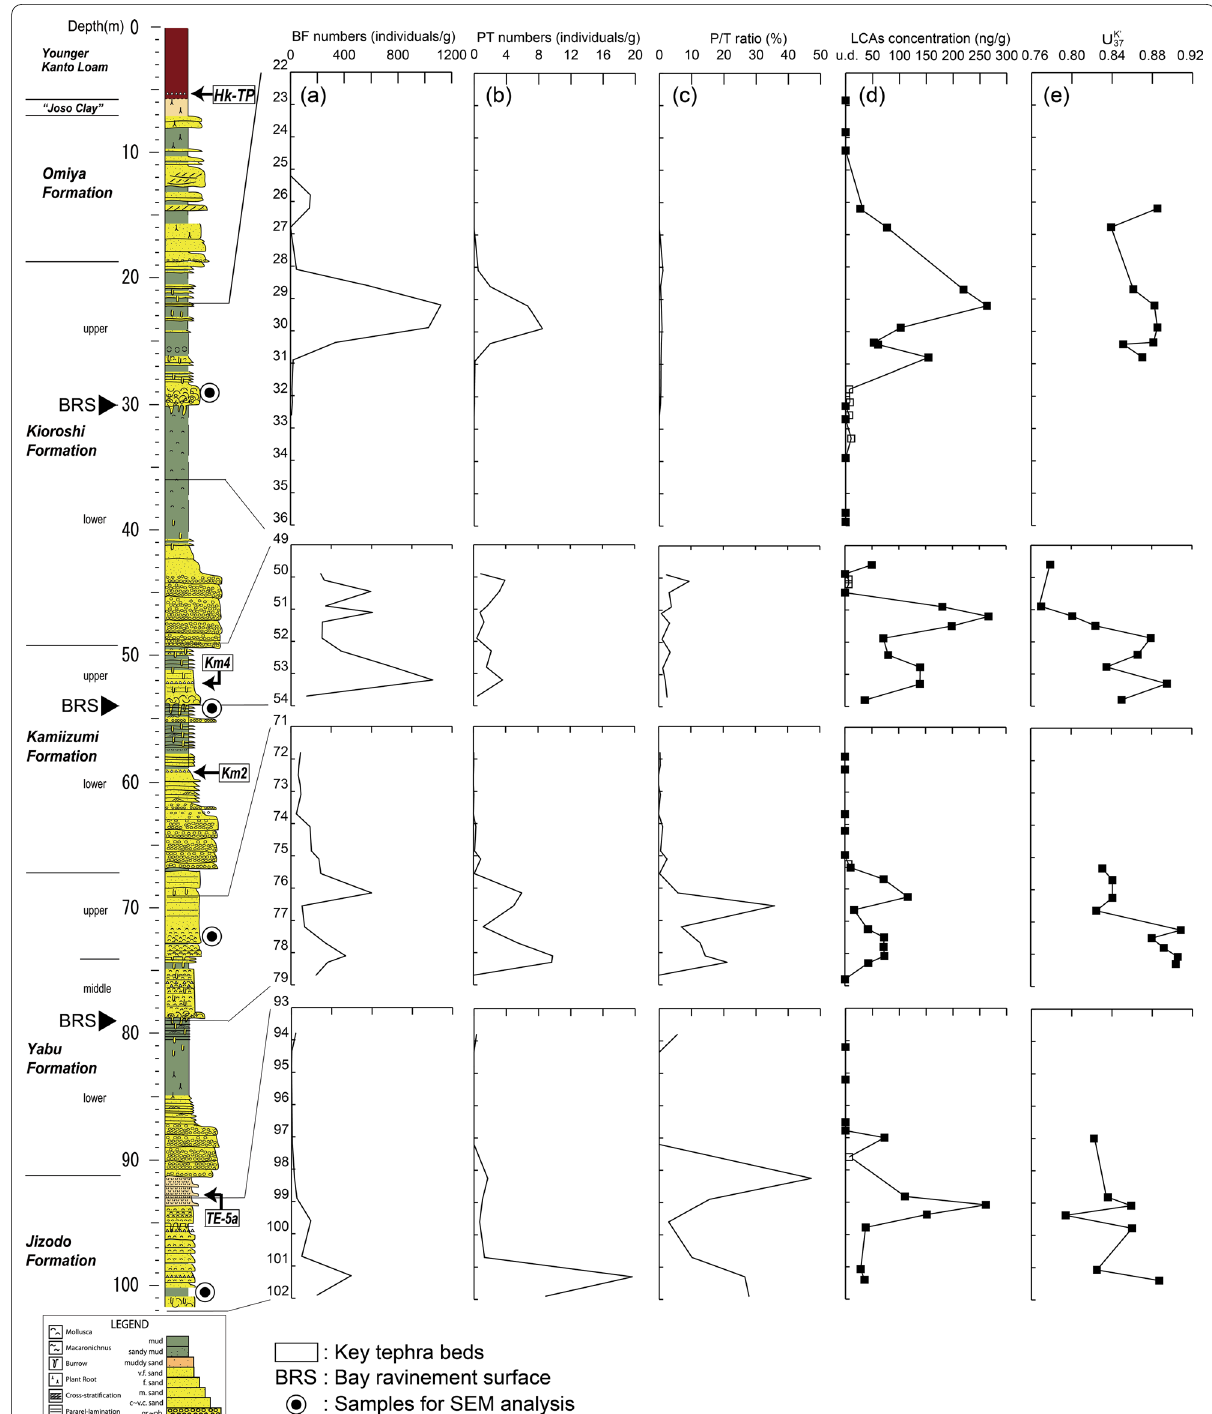
Fig. 5 Results of LCA concentration and U K ′ 37 -SST. The stratigraphic horizons examined in this study are shown in the left column with the columnar section of core GS-UR-1 described in Nakazawa and Nakazato (2005). a – c Variations in the total number of benthic and planktic foraminifera along with their relative abundance (P/T ratio) (Kaneko et al. 2018). d – e Variations in the LCA concentrations and U K ′ 37 -SSTs shown in this study. The white dots represent the samples in which LCAs were identified by GC/MS analysis, but clearly separated peaks could not be obtained by the GC